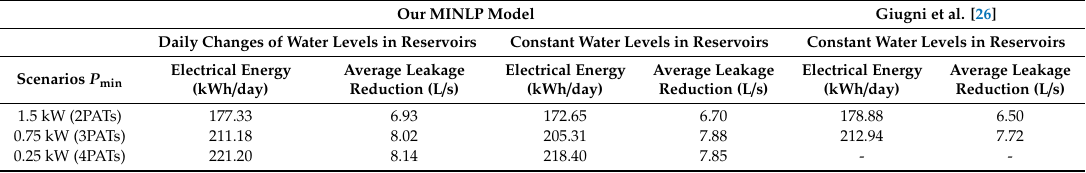
Table 3. Comparisons of Energy Production and Water Leakage Flows.